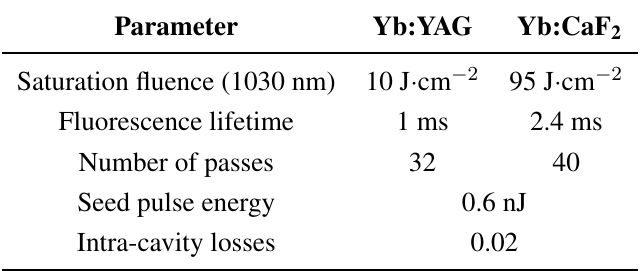
Table 1. Parameters used for regenerative amplifier